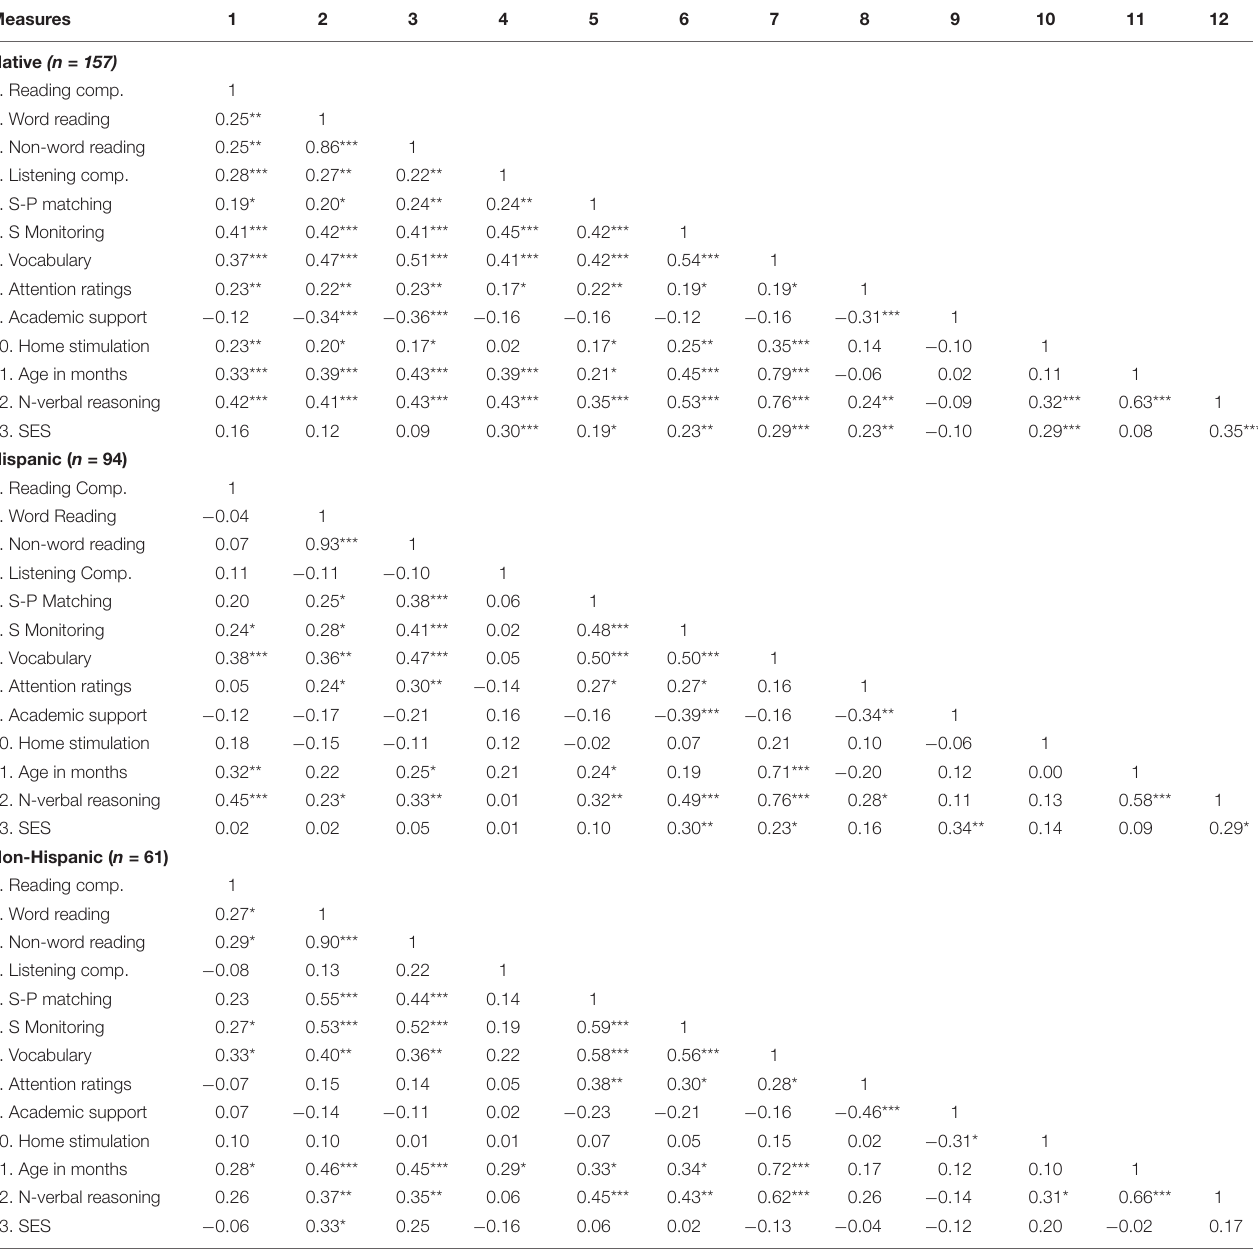
TABLE 3 | Correlations among all measures for Native, Hispanic, and Non-Hispanic children.